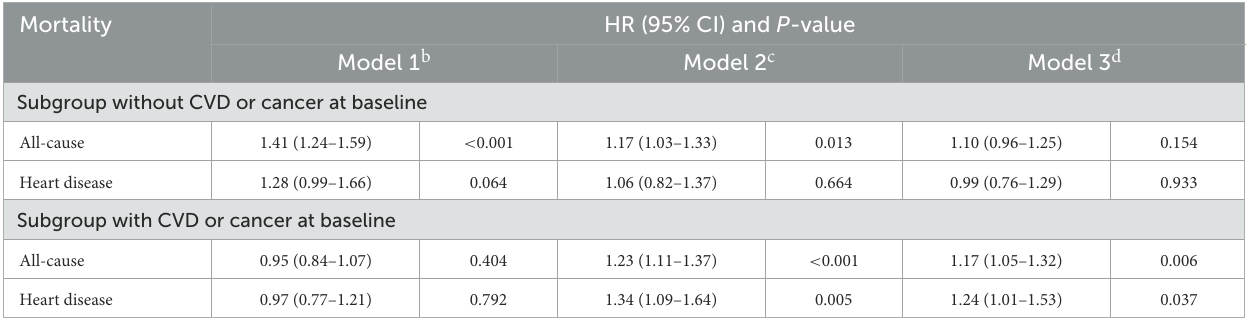
TABLE 3 Associations of sleep complaints with all-cause and heart disease mortality in subgroups with or without CVD or cancer a .